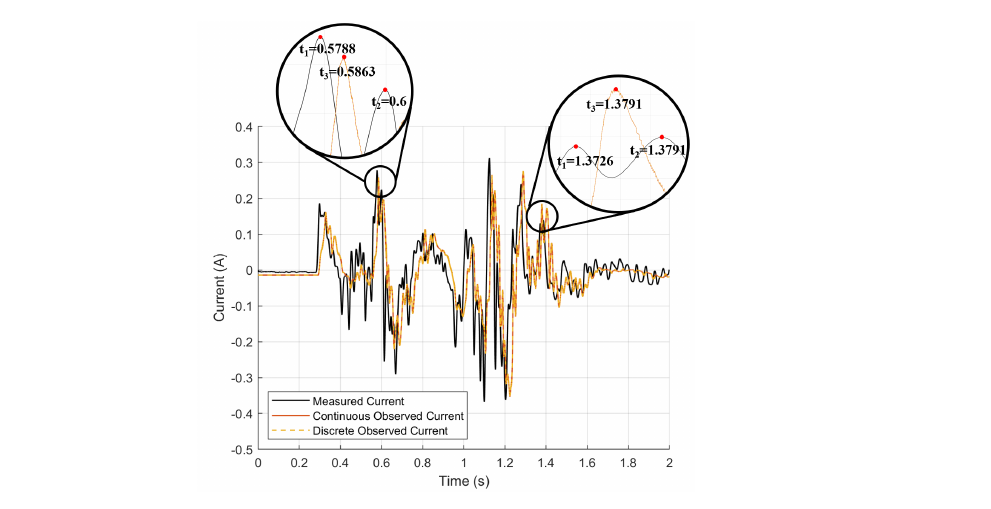
Figure 16. Disturbance observer simulation. The black curve is the input current of the disturbance actuator, which is proportional to the input disturbance. The red curve is the observed disturbance from the measured displacement with the continuous transfer function. The yellow curve is the observed disturbance with the discrete transfer function.